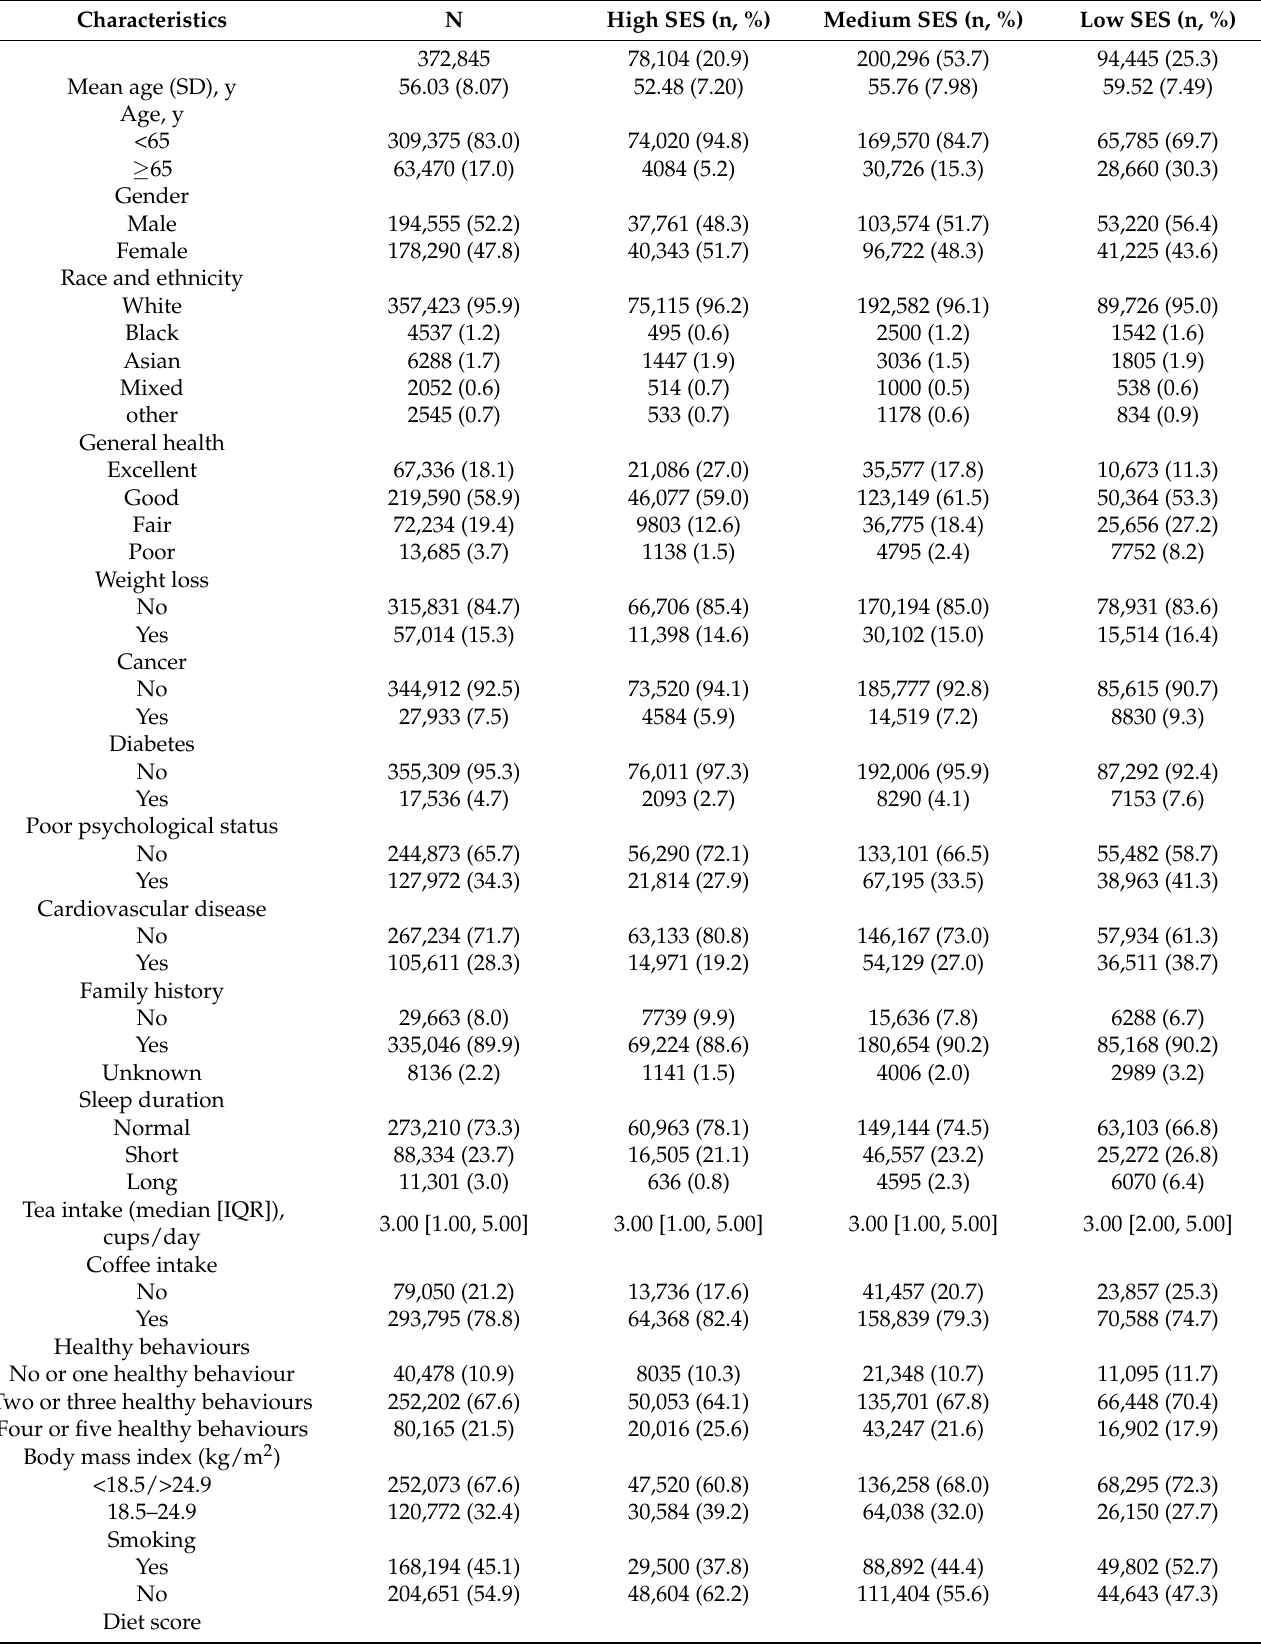
Table 1. Baseline characteristics of